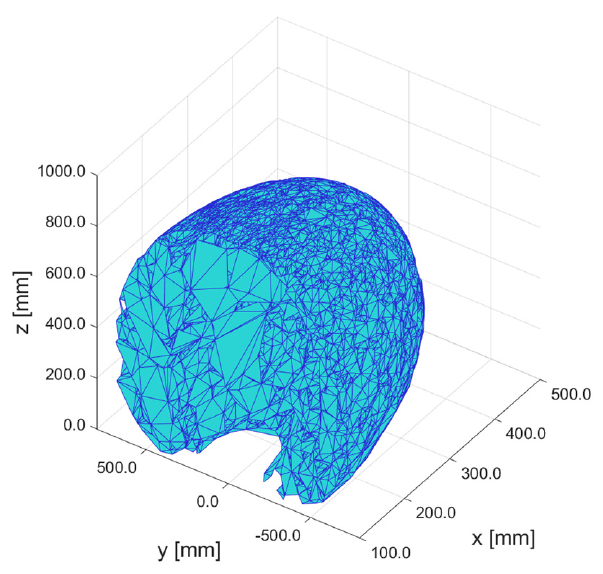
Figure 12. Constrained workspace for the FANUC LR Mate 200iC.